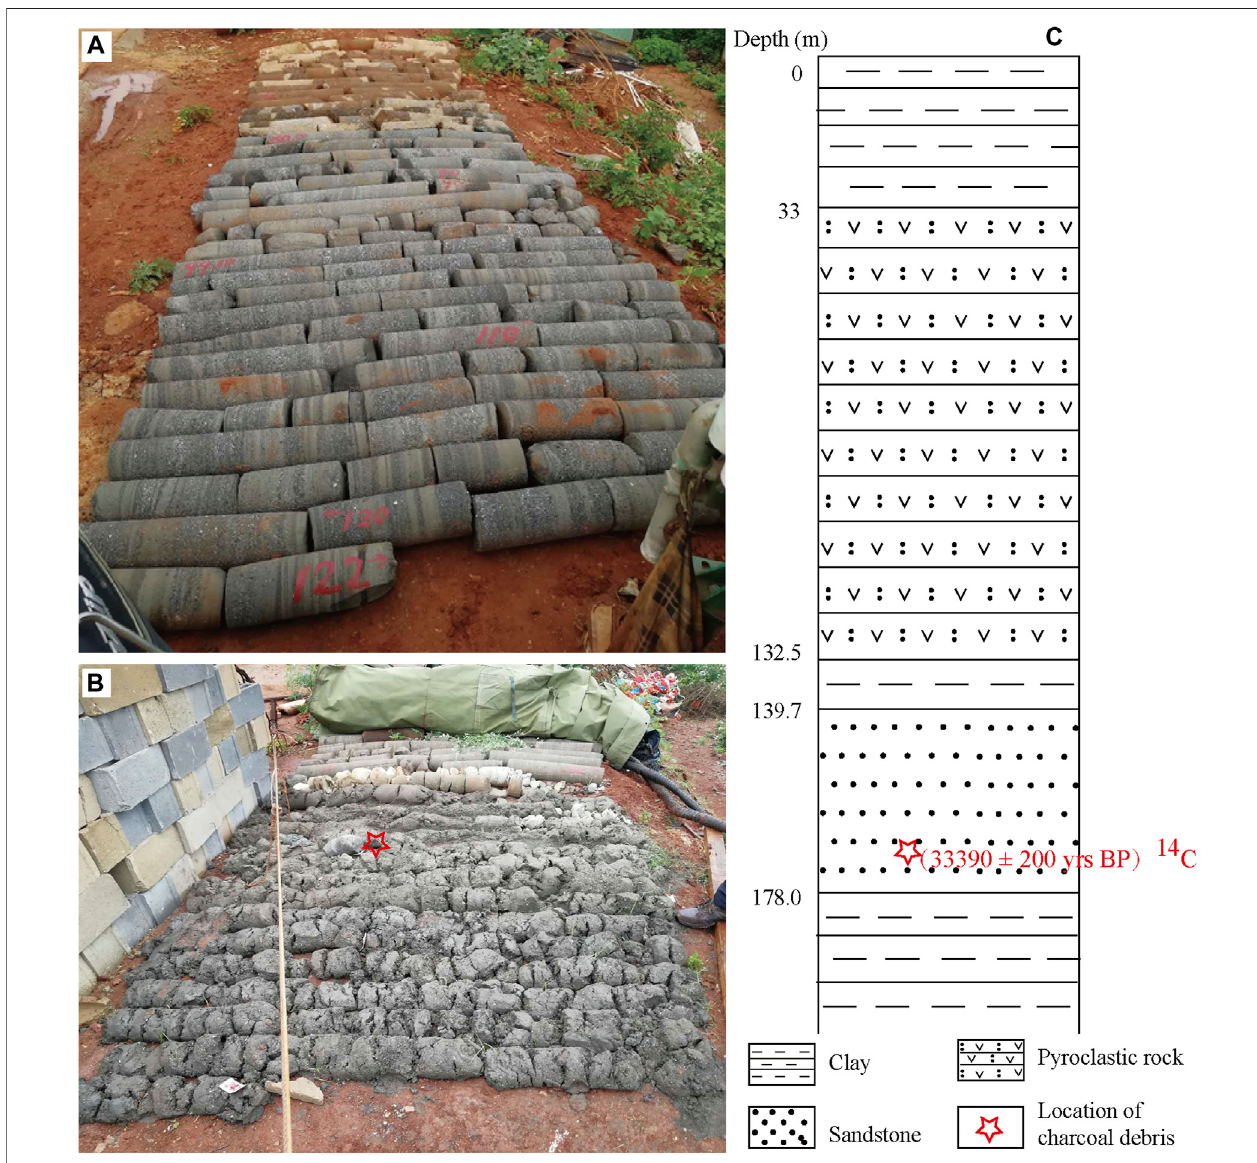
FIGURE 5 | Drilled core from Daling. (A) Upper part of the core. (B) Lower part of the core. (C) Stratigraphic column of the Daling borehole.